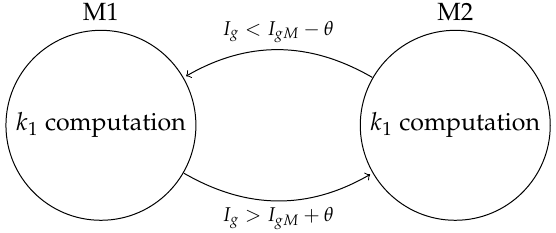
Figure 6. Supervisor: Energy management automaton. M1 = constant inductor current, M2 = constant generator